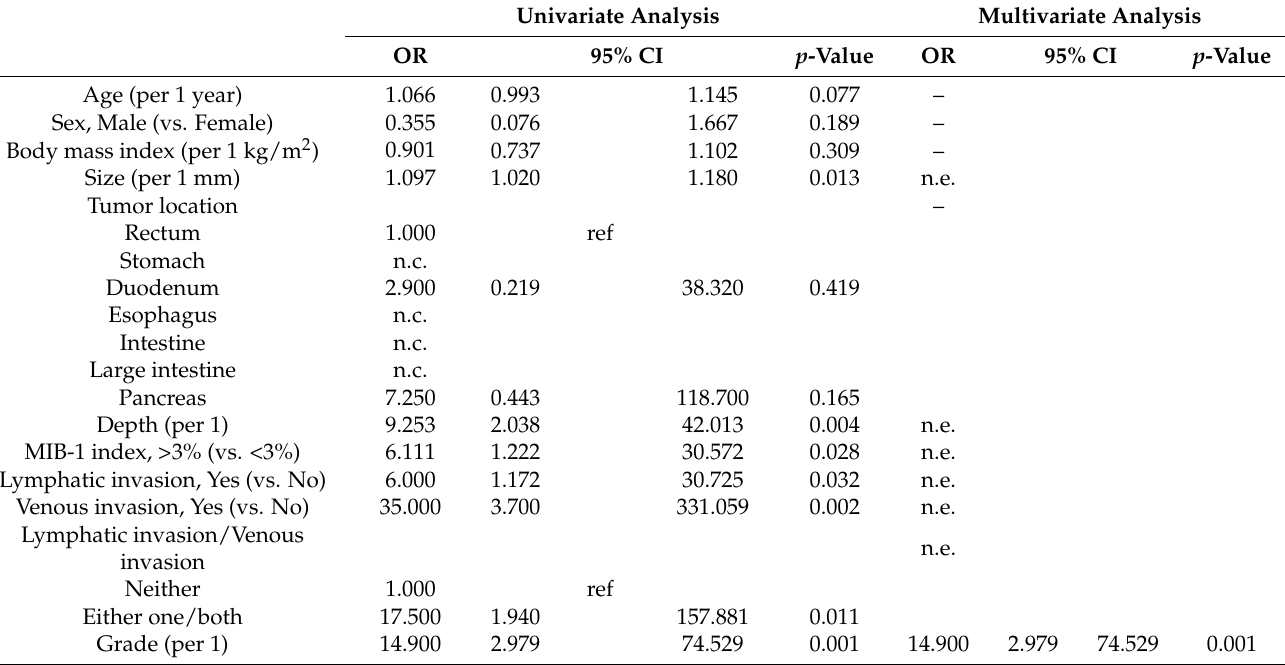
Table 3. Logistic regression analysis for all